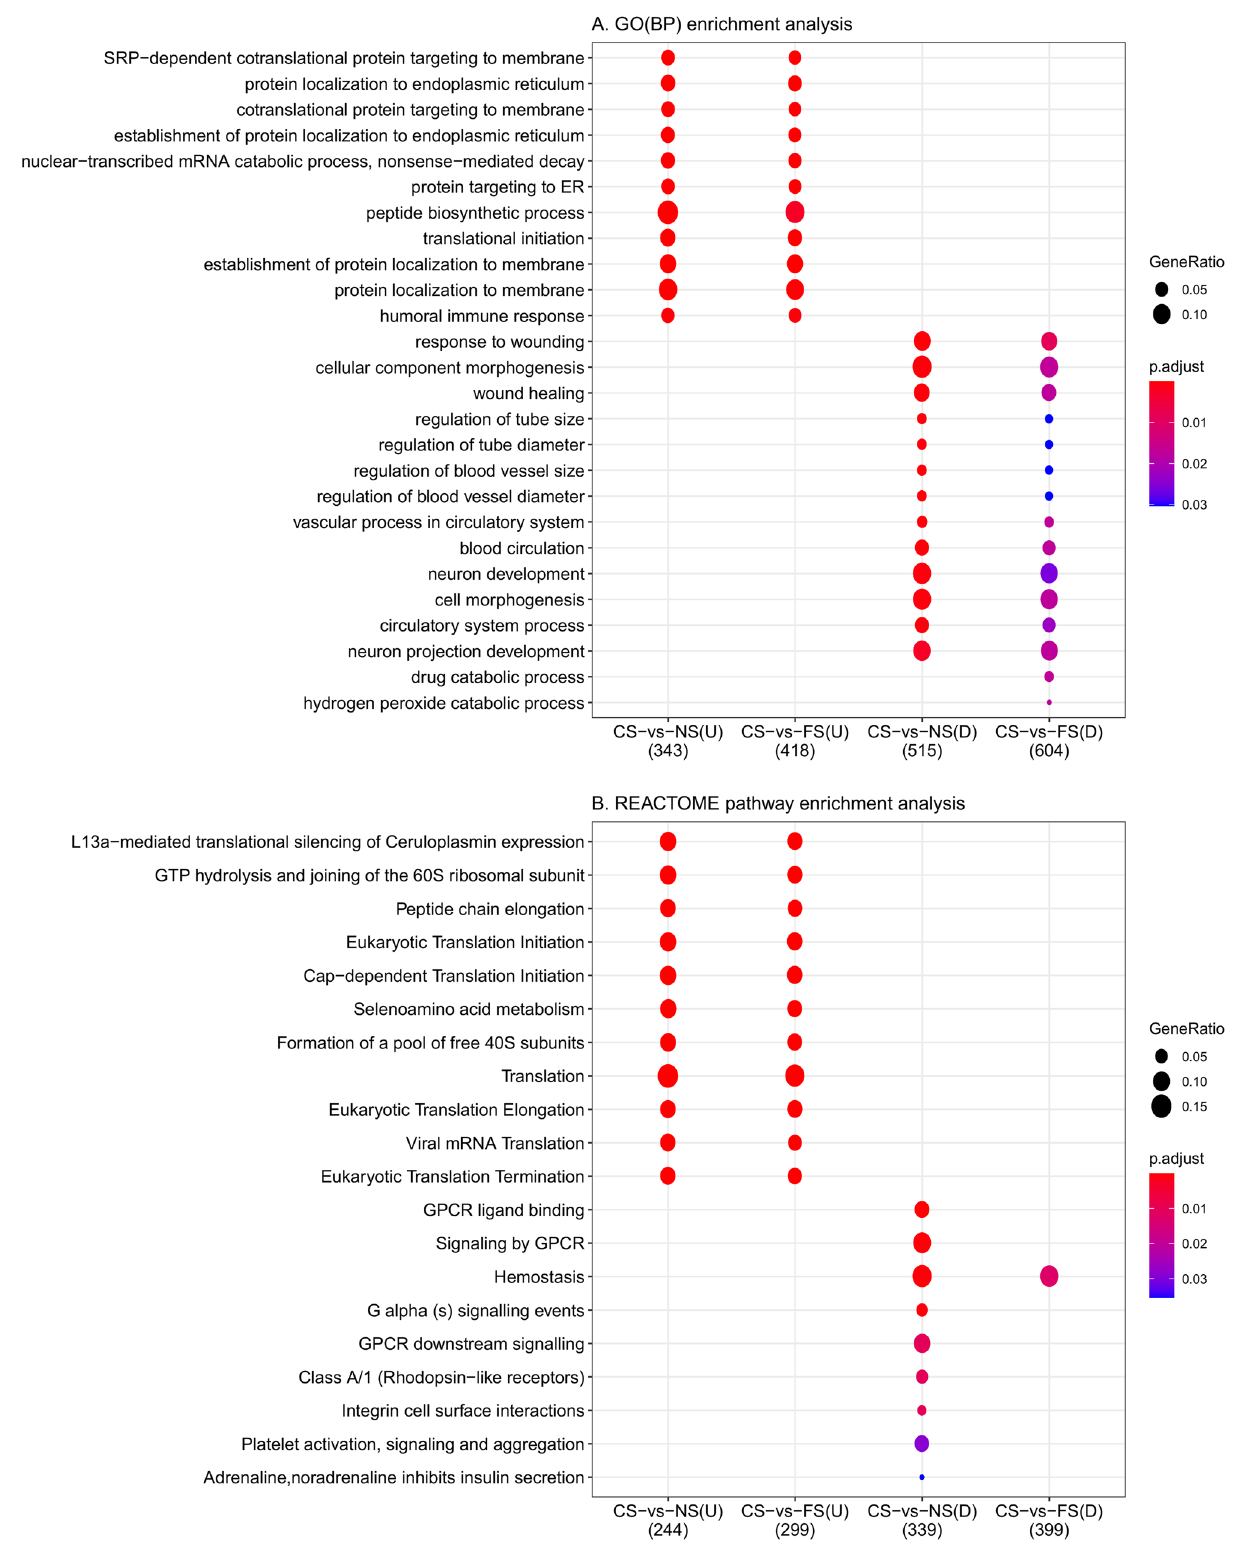
Figure 5. Summary of functional enrichment analyses for up- and down-regulated genes for the ( A ) GO(BP) and ( B ) REACTOME pathway databases. The colour of the dots indicates the adjusted p-value, where red dots represent the most enriched categories; the ‘GeneRatio’ indicates the proportion of genes overlapping between lists of differentially expressed genes (DEGs) and the genes in gene ontology categories. GO: gene ontology; BP: biological processes; CS-vs-NS: comparison of current smokers versus never smokers; CS-vs-FS: comparison of current smokers versus former smokers; U: Up-regulated genes; D: Down-regulated